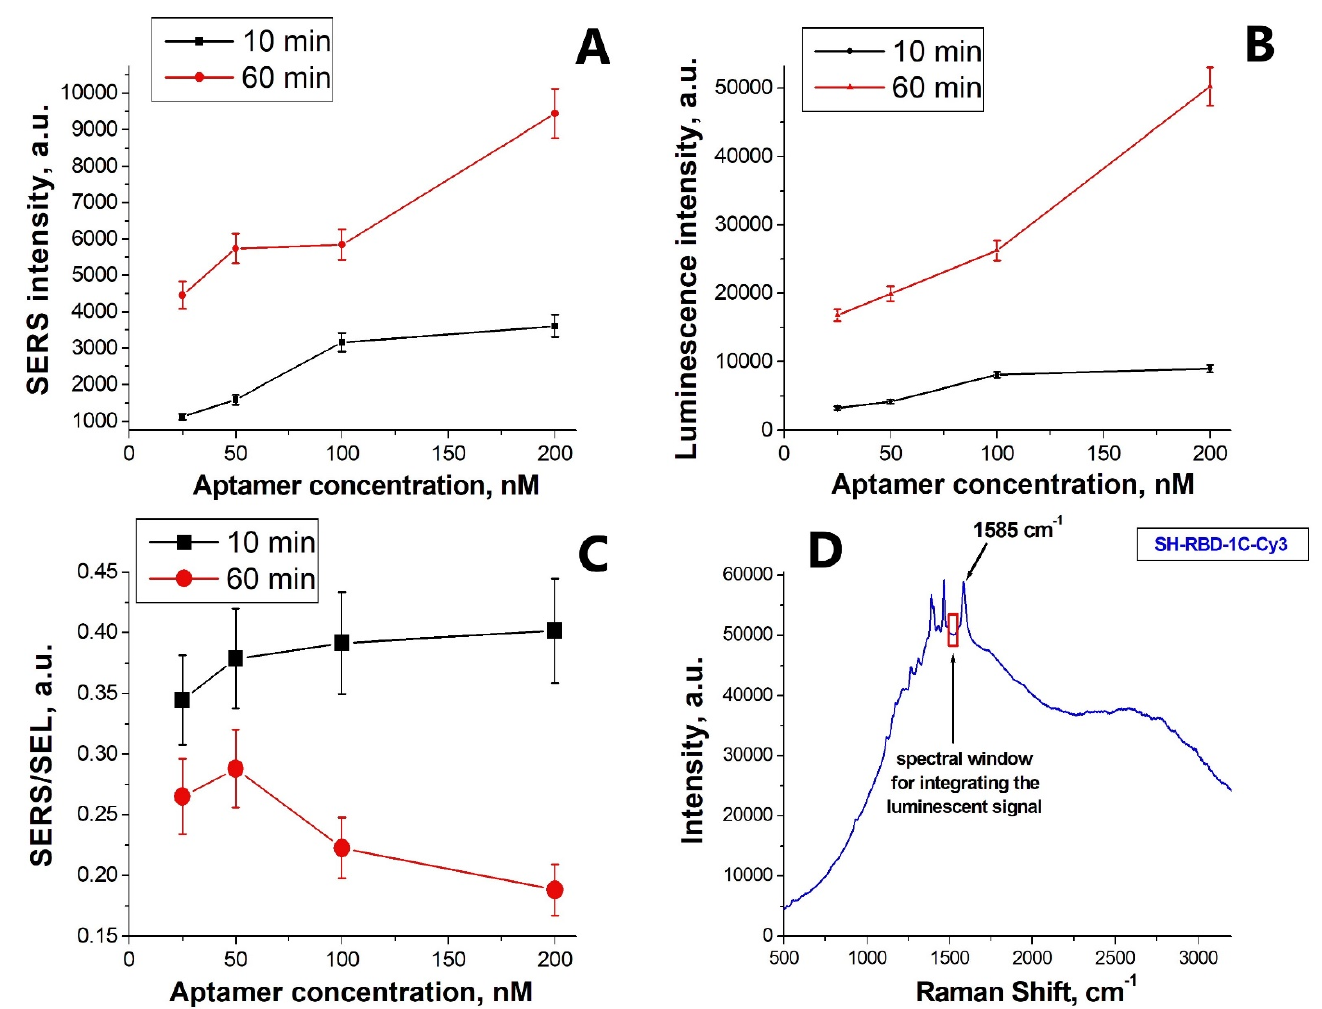
Figure 4. The effect of the concentration of the SH-RBD-1C-Cy3 aptamer on the SERS and SEL optical signals from the Cy3 label, observed for the incubation times of 10 and 60 min. ( A ) Variation in the SERS signal. ( B ) Variation in luminescence (expressed as a volume luminescence signal and a surface- enhanced luminescence signal). ( C ) Variation in the ratio of the SERS signal to the luminescence signal. ( D ) SERS spectrum of the SH-RBD-1C-Cy3